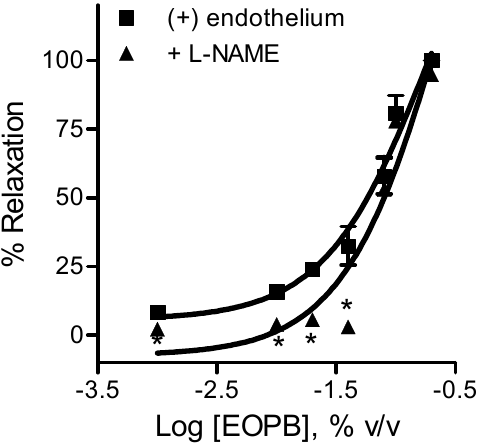
Figure 3. Effects of essential oil of Pectis brevipedunculata (EOPB) on endothelium-intact aortic rings from WKY rats in the presence of L -NAME (100 μ M). Concentration-response curves for EPPB in aorta precontracted with phenylephrine. Data are mean ± SEM (n = 4). * p < 0.05 vs. (+) endothelium.